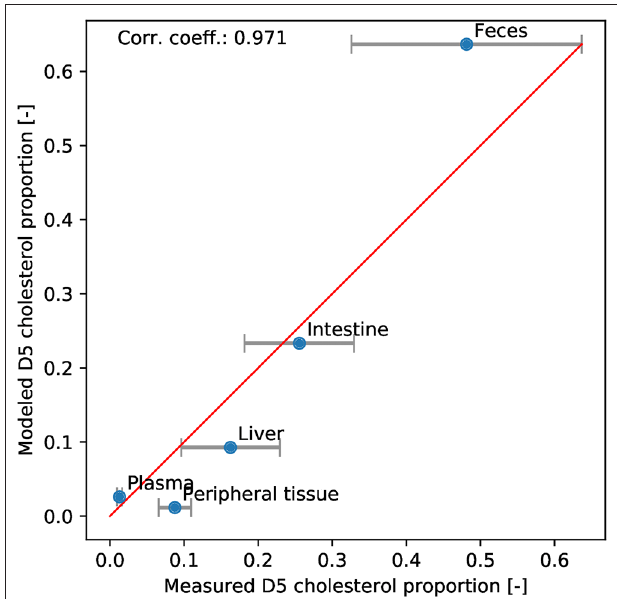
FIGURE 4 | Model validation. The deuterated cholesterol distribution in compartments obtained with the model is plotted against the experimental one. Errorbars representing the SEM of the experimental data are added. We observe that the points follow the y = x line (red) with a high correlation coefficient